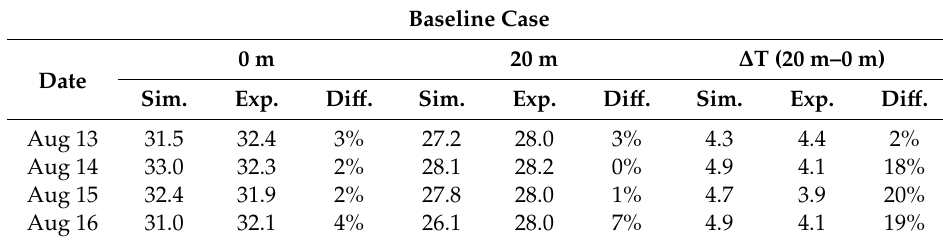
Table 3. Baseline simulation results.